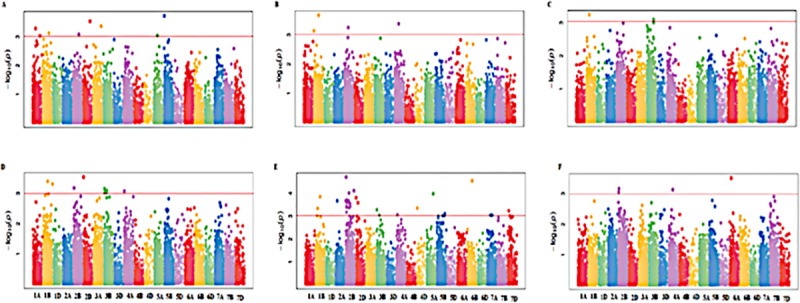
Manhattan plots showing SNP markers associated with different traits using CMLM at p-value <0.001.A. DTH, B. DTM C. RS under non-stress conditions, and D. DTH, E. DTM and F. RS under drought-stress conditions. The horizontal red line represents FDR adjusted p< 0.001.